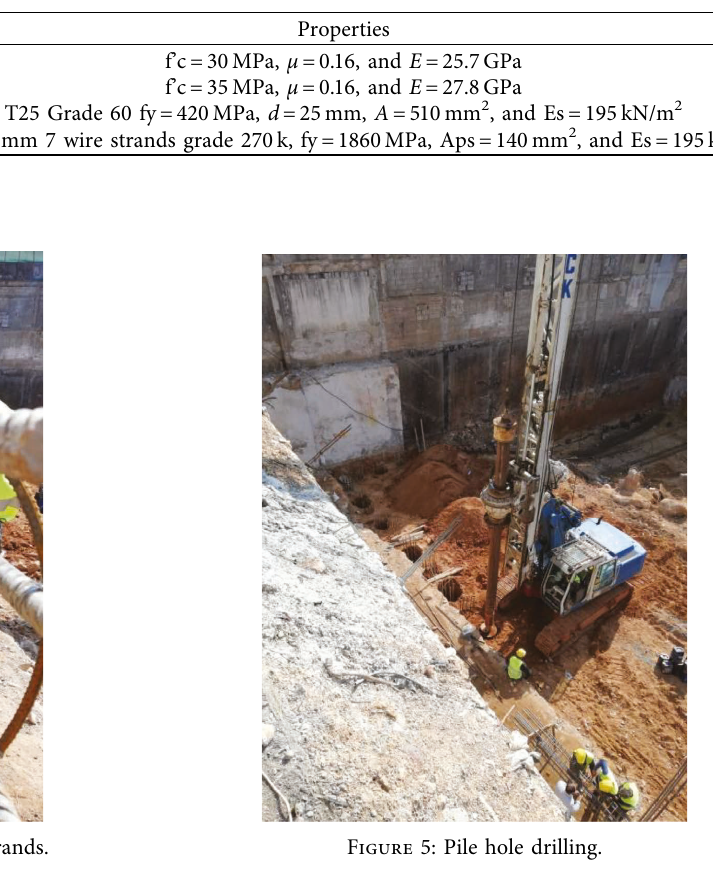
Table 2: Properties of raw material.